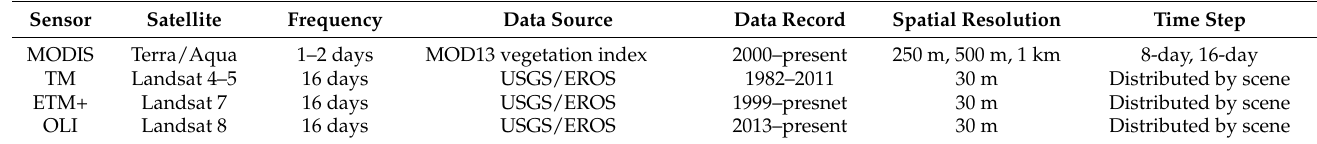
Table 1. Remote sensing image data source for Great Khingan Mountain (GKM),